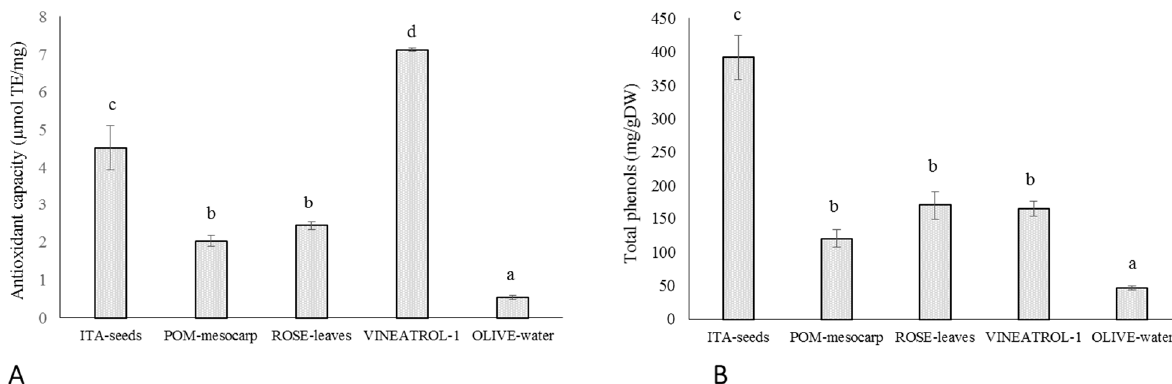
Figure 1. Antioxidant features of plant food-derived matrices and a commercial food supplement. ( A ). The antioxidant capability of extracts from ITA-seeds (seeds from V. vinifera L. cv. Italia), ROSE-leaves (leaves from Rosmarinus officinalis L.) POM-mesocarp (mesocarp of Punica granatum L. cv. Wonderful fruits) OLIVE-water (water obtained from olive milling), VINEATROL-1 (a food supplement from Breko GmbH, Bremen, Germany) was determined as ABTS scavenging activity by TEAC assay. Results are expressed as Trolox equivalent µ mols per mg of dry sample. ( B ). The total content of phenols of the same samples have been determined by Folin–Ciocalteau method and expresses as mg per dry weight g of sample. Different letters (a), (b), (c), (d) indicate a statistical difference ( p < 0.05) according to